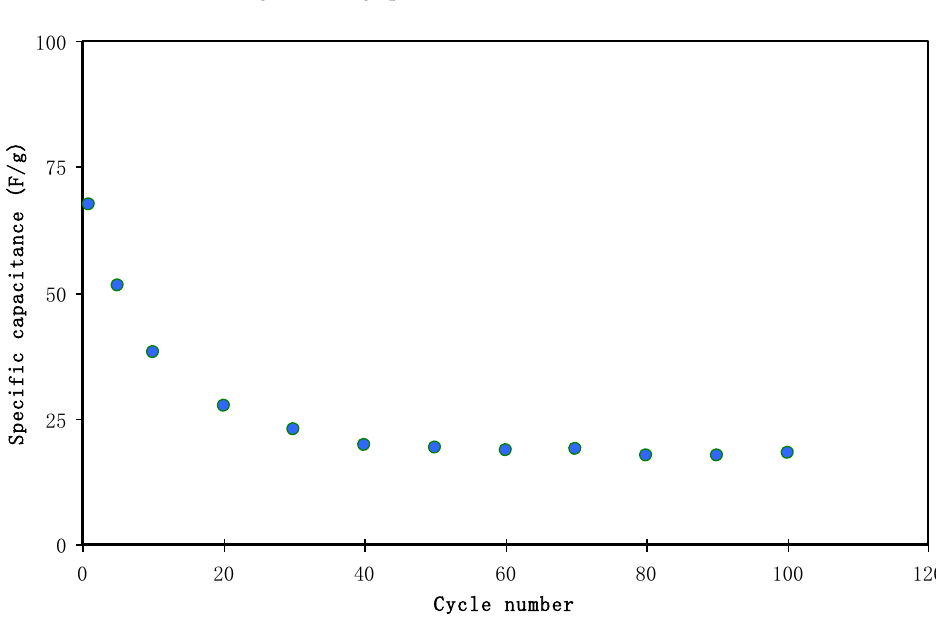
Figure 11. Specific capacitance of the assembled EDLC for 100 cycles. Table 2. Carbon-based EDLC